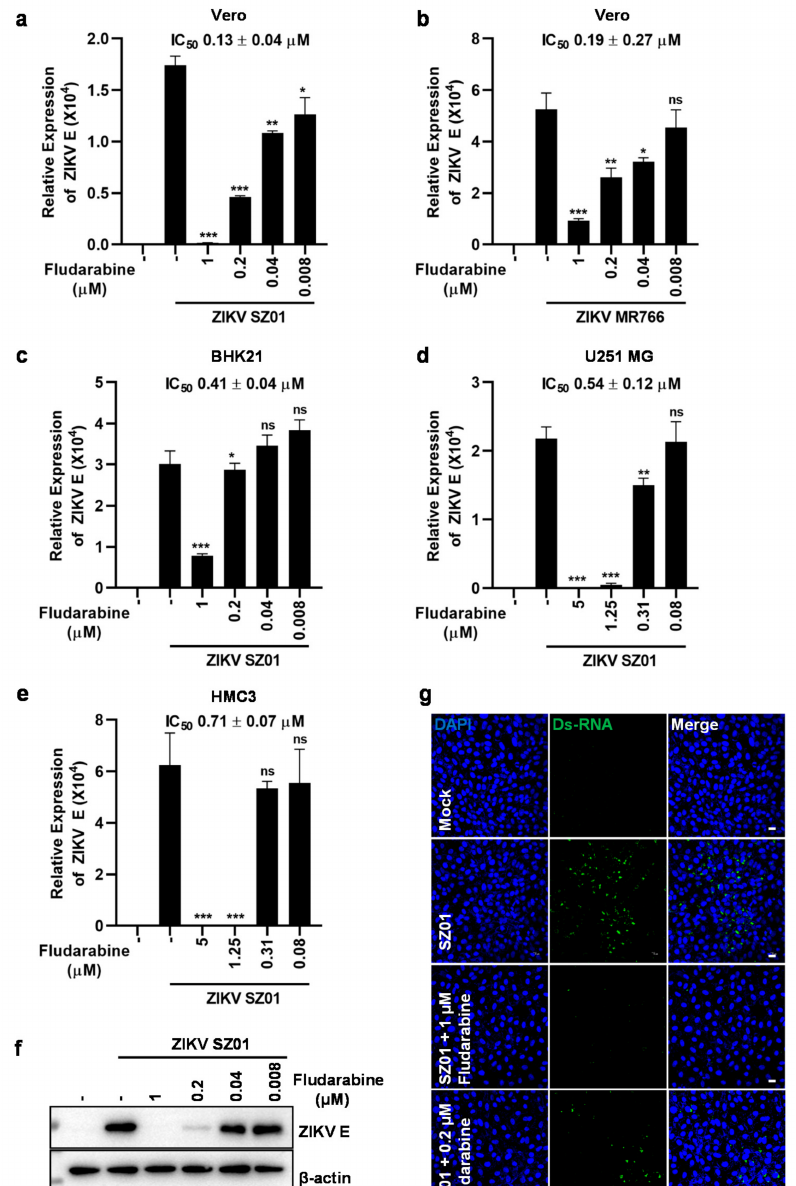
Figure 2. Fludarabine inhibited infection of ZIKV. ( a , b ) Inhibitory effect of fludarabine on ZIKV SZ01 and MR766 infection in Vero cells. ( c – e ) Inhibitory effect of fludarabine against ZIKV SZ01 infection in BHK21, U251 MG and HMC3 cells, respectively. Fludarabine, diluted to 1, 0.2, 0.04, and 0.008 µ M or 5, 1.25, 0.31, and 0.08 µ M, was mixed with 0.1 MOI of ZIKV SZ01 or ZIKV MR766. After the mixture was inoculated to cells for 2 h, the mixture was discarded and the cells were washed twice with PBS. The cell cultures were supplemented with DMEM or MEM (2% FBS) containing fludarabine of the same concentration as mentioned above. Total RNA was prepared 24 h later to measure ZIKV E gene transcription by qRT-PCR assay. The differences between infected-groups without and with treatment of fludarabine were evaluated by two-tailed Student’s t test. Data are presented as mean ± SD; *, p < 0.05; **, p < 0.01; ***, p < 0.001; ns, no significance; -, no fludarabine was added. ( f ) Decrease of viral protein in ZIKV-infected cells treated with fludarabine. The expression of ZIKV SZ01 E protein was measured by western blot analysis after the Vero cells were treated for 36 h as mentioned above. -, no fludarabine was added. ( g ) Anti-ZIKV activity of fludarabine was tested using immunofluorescence analysis. After the Vero cells were treated for 24 h as mentioned above, ZIKV SZ01 dsRNA was detected by immunostaining with J2 anti-dsRNA monoclonal antibody (green). Cell nuclei were stained by 40, 6-diamidino-2-pheny-lindole (DAPI, blue). Scale bars, 20 µ